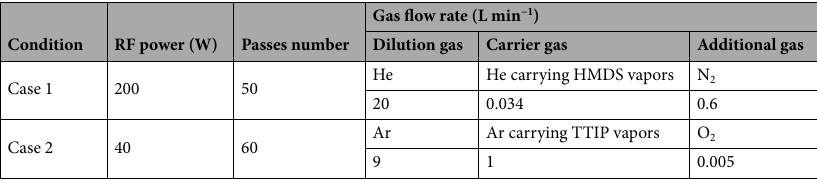
Table 1. Atmospheric-pressure plasma deposition